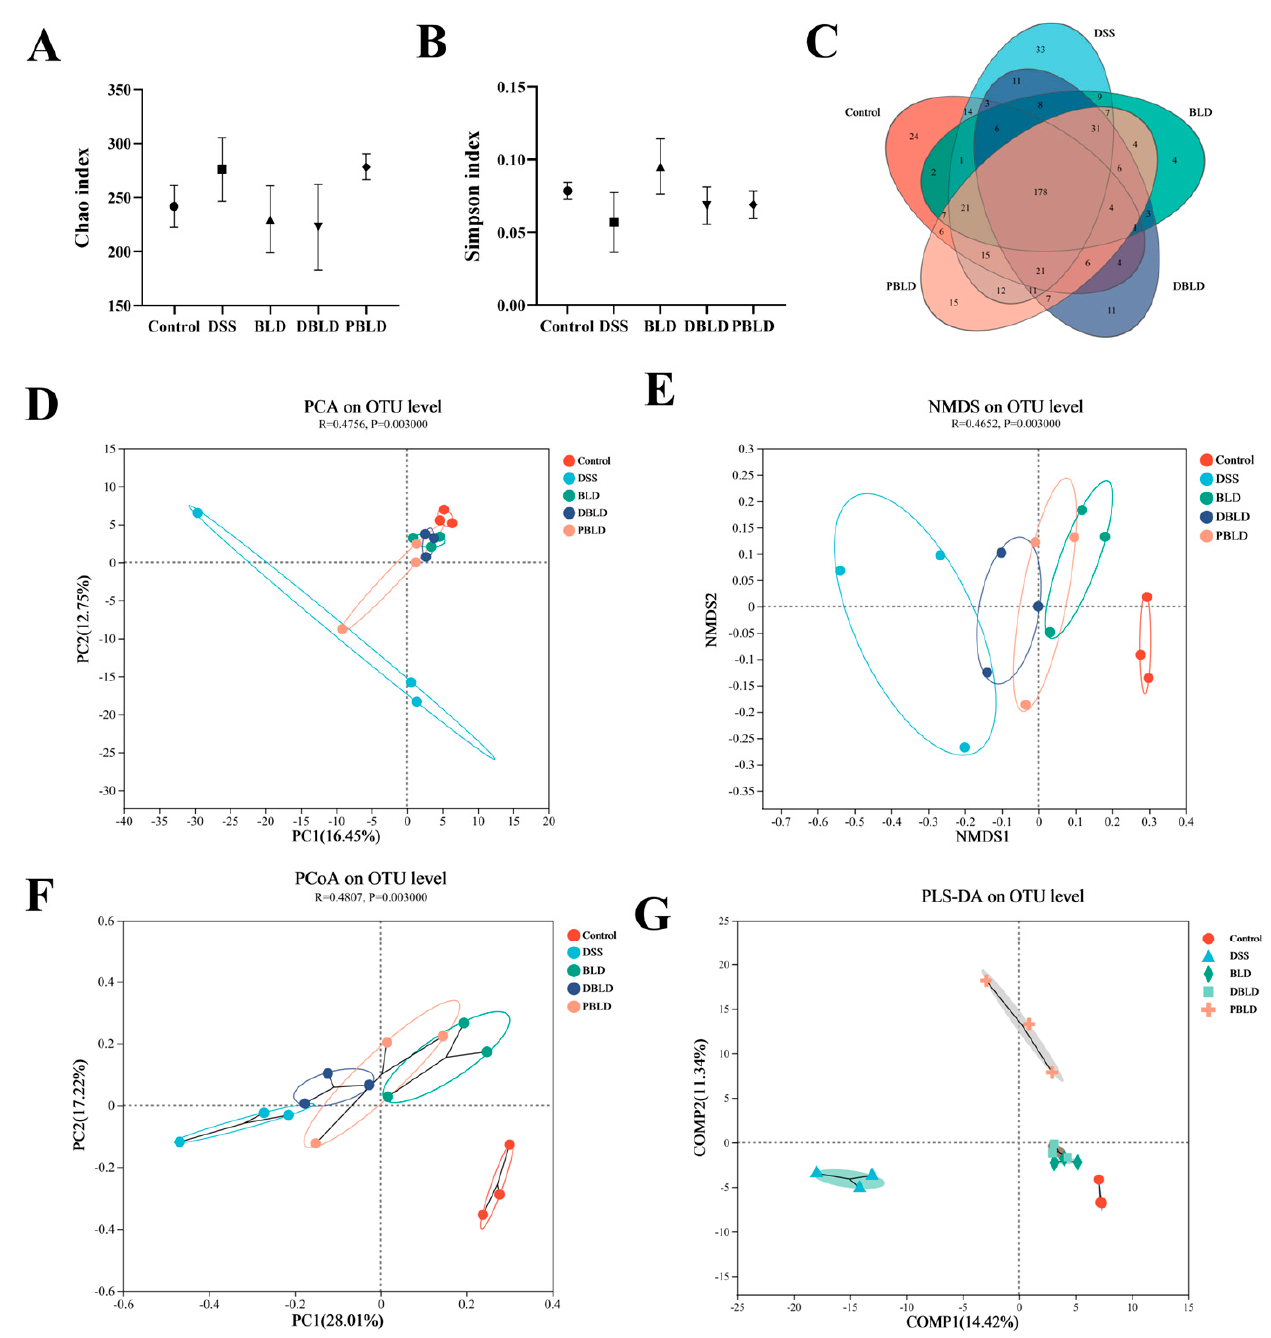
Figure 6. Analysis of intestinal microbial diversity. ( A ) Chao index. ( B ) Simpson index. ( C )